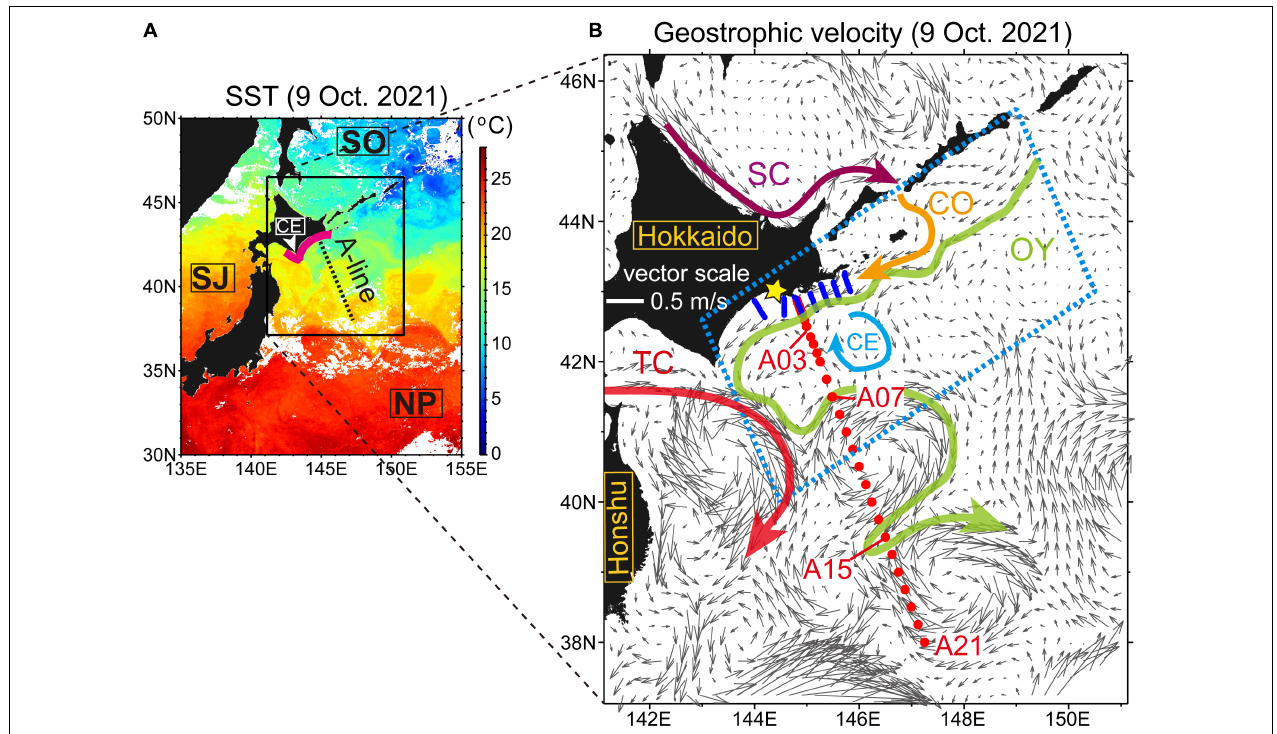
FIGURE 1 | (A) Himawari-8-derived sea surface temperatures around Japan on 9 October, 2021. White areas denote clouds. Geographic names are enclosed in rectangles: SJ, Sea of Japan; SO, Sea of Okhotsk; NP, North Pacific; and CE, Cape Erimo. The bold magenta line roughly indicates coastal waters where fisheries experienced devastating damages that were attributable to harmful algal blooms after mid-September 2021. (B) Absolute geostrophic velocity at the sea surface, estimated from near-real-time gridded altimetry products. Closed red and blue circles indicate conductivity–temperature–depth (CTD) stations along the A Line and L lines, respectively. The star symbol indicates the location of the Katsurakoi fishery harbor. Schematic flow patterns are depicted by colored vectors: SC, Soya Warm Current; CO, Coastal Oyashio; OY, Oyashio; TC, Tsugaru Warm Current; and CE, clockwise eddy. Positions where the Oyashio crossed the A Line were determined on the basis of 5 ◦ C isotherms at 100-m depth. Daily areal extents of satellite-derived chlorophyll- a concentrations were estimated within the blue dashed square ( Figure 2 ).